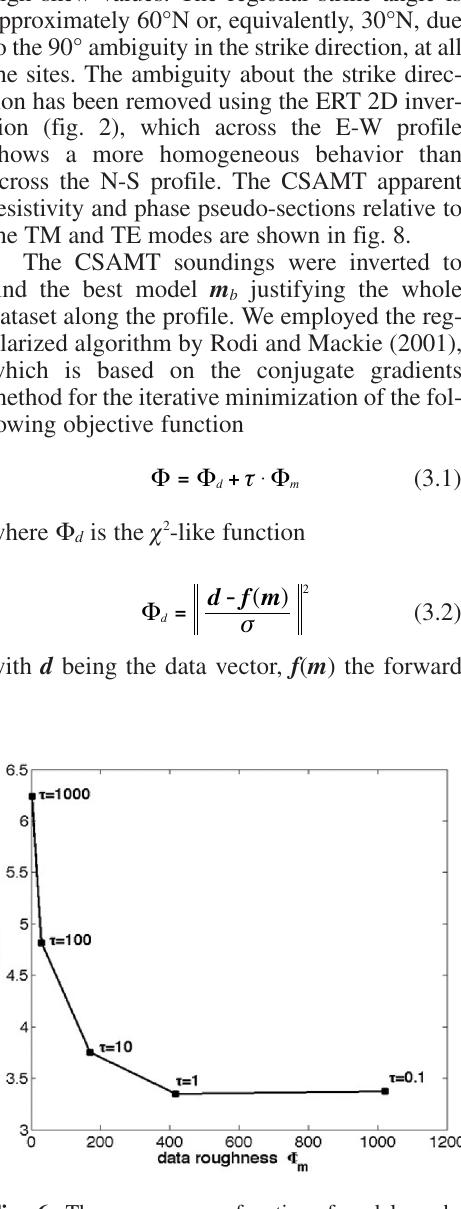
Fig. 6. The rms error as a function of model rough- ness relative to different values of the trade-off pa- rameter